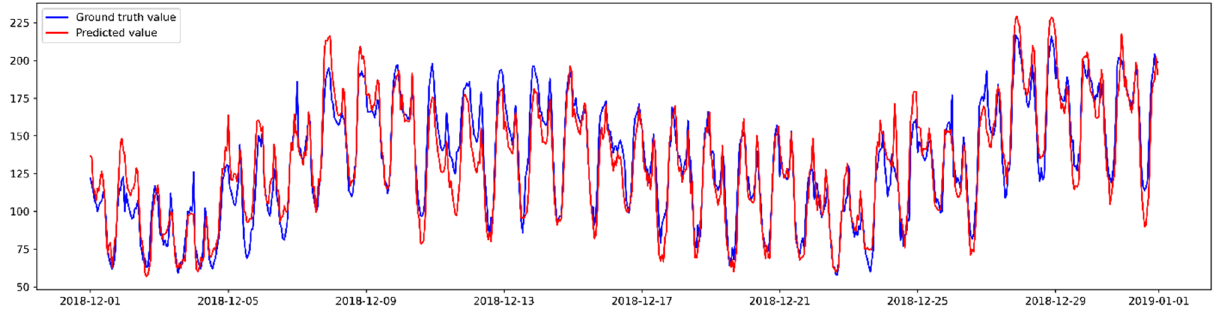
Figure 9. Daily heat load prediction results on the seasonal heat variation test set using the XGBoost